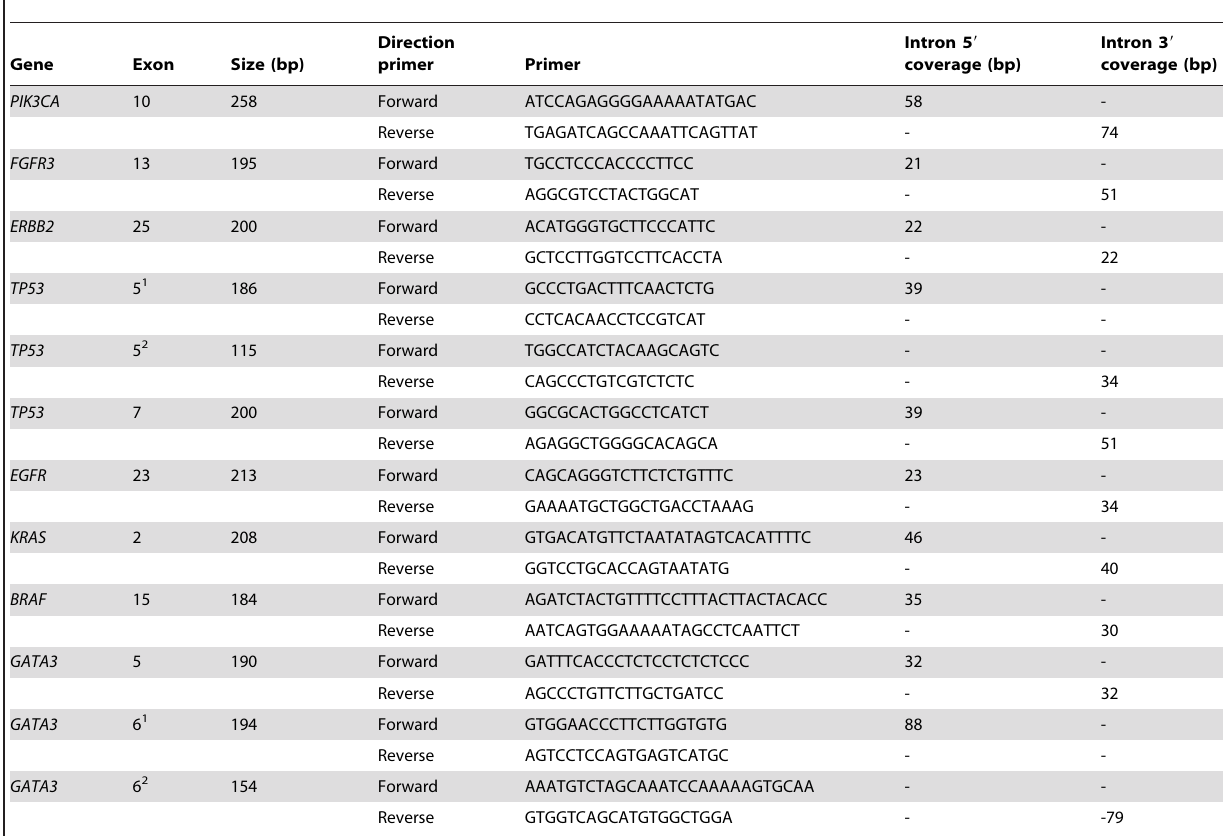
Table 1. Primers for pre-HRM DNA